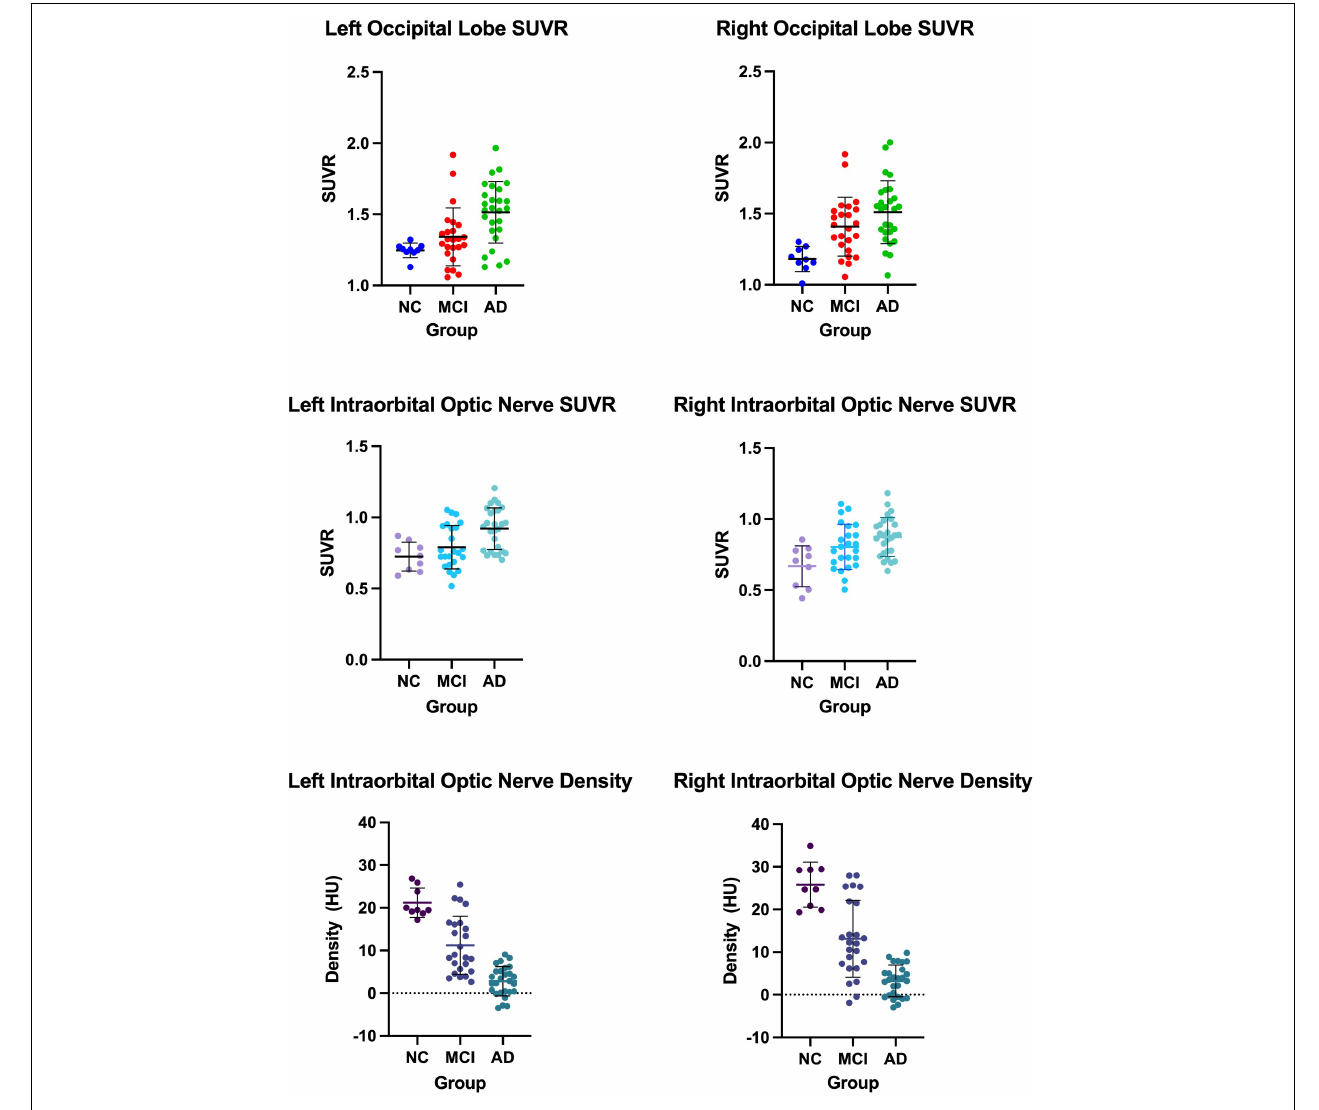
FIGURE 1 | The occipital standardized uptake value ratio (SUVR), the intraorbital optic nerve SUVR, and the intraorbital optic nerve density of three groups.